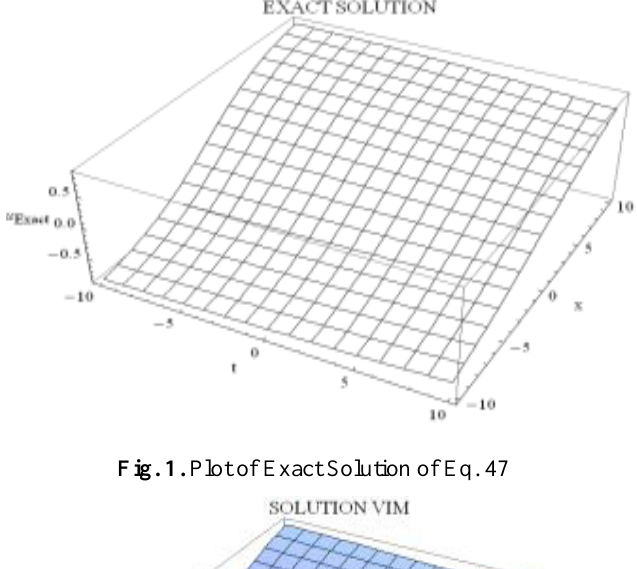
Fig. 1. Plot of Exact Solution of Eq. 47